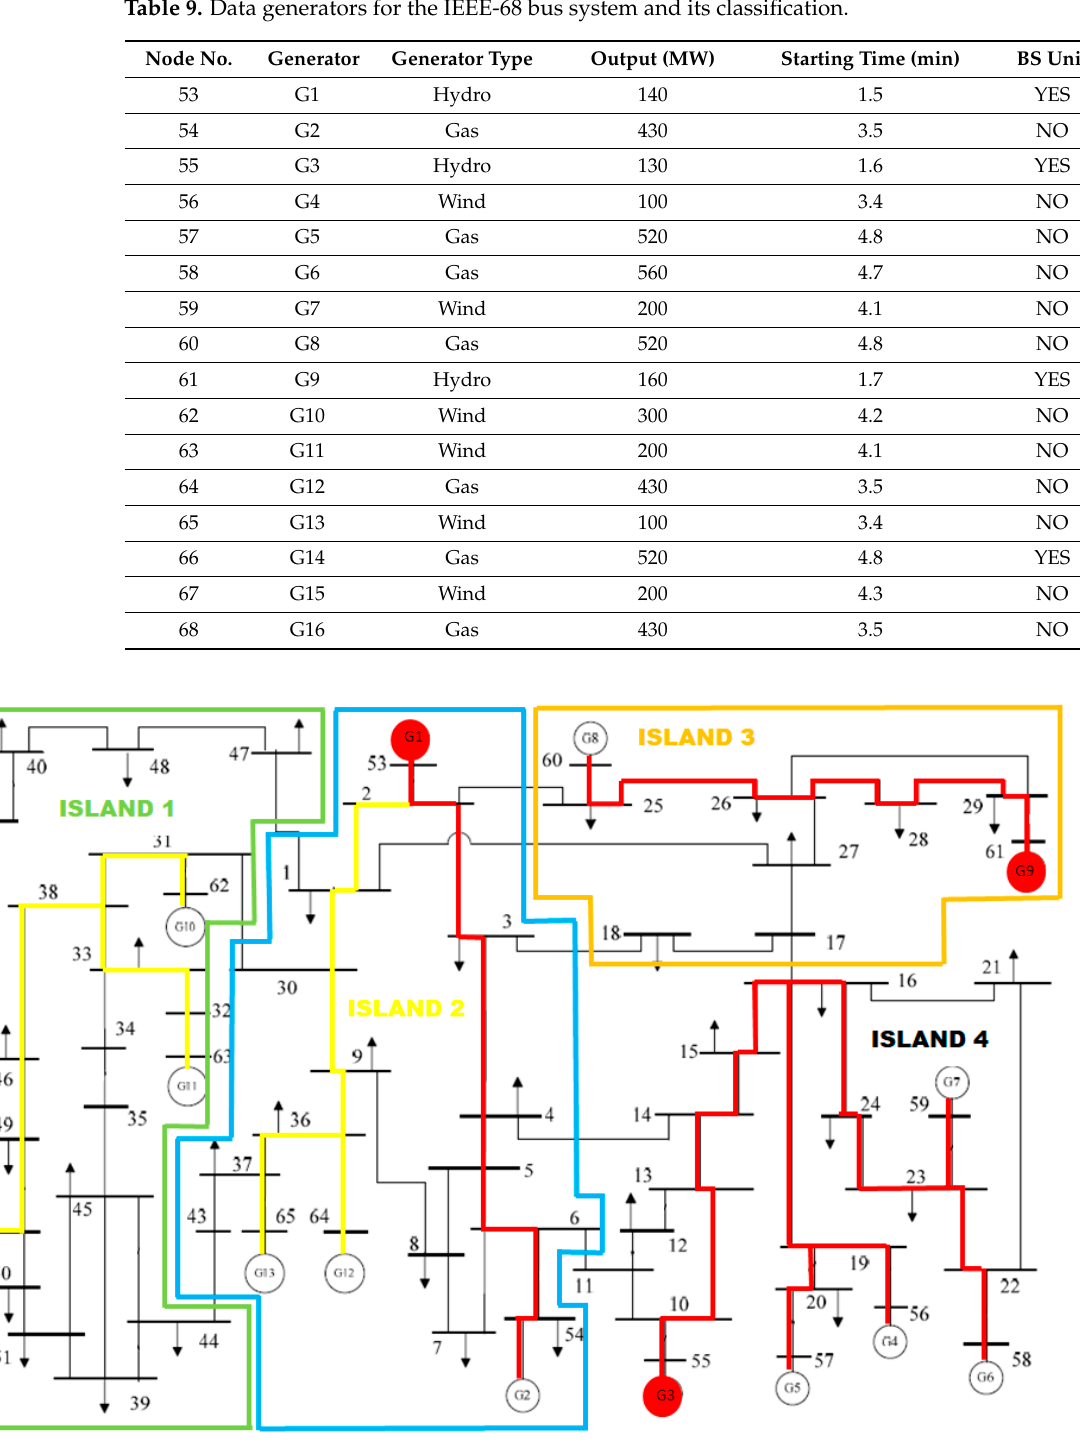
Table 8. Cranking paths from BS unit to NBS unit. Island BS Unit NBS Unit Critical Loads to be Restored Cranking Path (Bus No.)